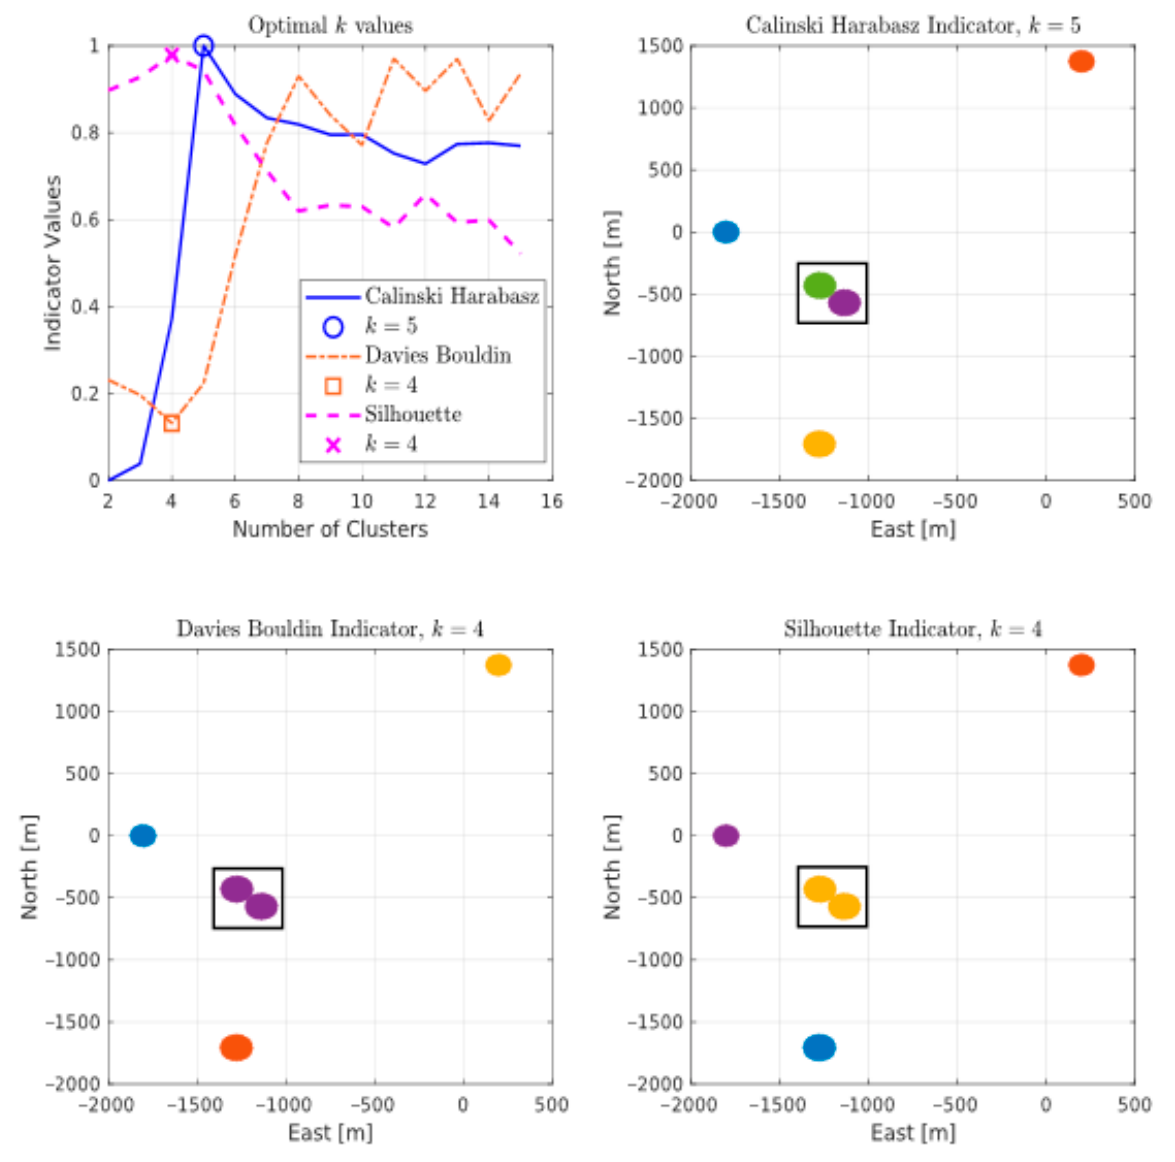
Figure 4. An exemplar output of cluster evaluation on MANV at observation step t = 420 s. The upper left plot displays the criterion results denoting the optimal number of clusters k that were evaluated by the different indicators. The remaining plots are clustering results using the respective indicators. Calinski-Harabasz ( upper right ) was able to discern between point clouds from two targets while the remaining methods in the lower row, namely Davies Bouldin ( left ) and Silhouette ( right ), failed to. The indicator values for Calinski-Harabasz have been normalized for the sake of uniform comparison in the plot.